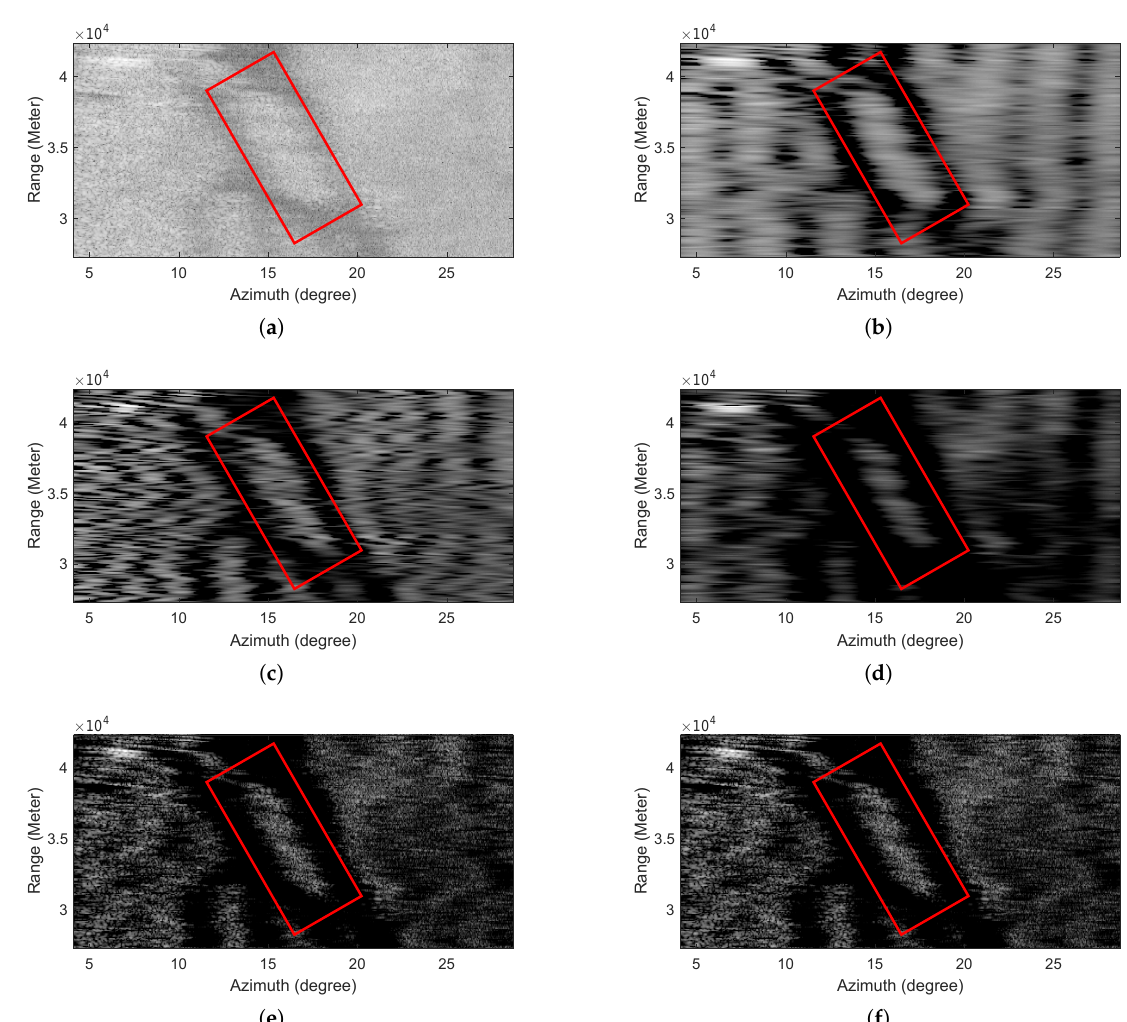
Figure 7. Real data 1 results. ( a ) Real-beam echo, ( b ) TSVD, ( c ) IAA, ( d ) Sparse, ( e ) TV, ( f ) GSFTV.